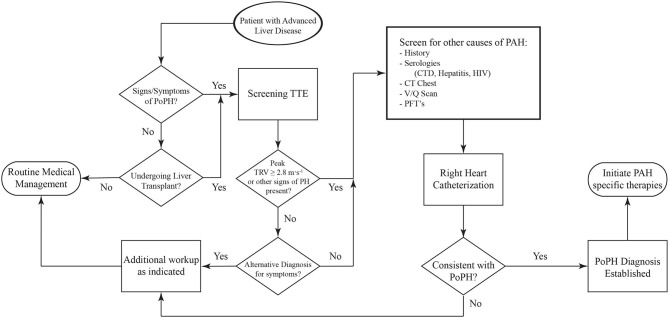
Algorithm for the diagnosis of PoPH. PoPH, Portopulmonary Hypertension; TTE, Transthoracic Echocardiogram; TRV, Tricuspid Regurgitant Velocity; CTD, Connective Tissue Diseases; PFT's, Pulmonary Function Tests.